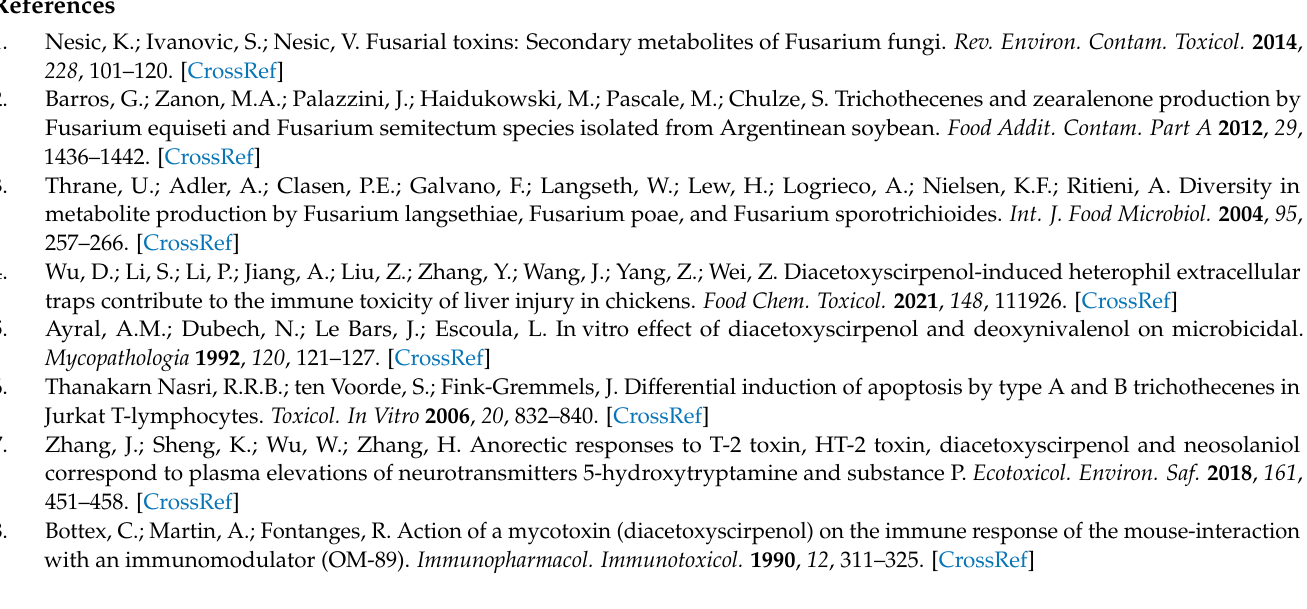
Table S1: Primers used for PCR